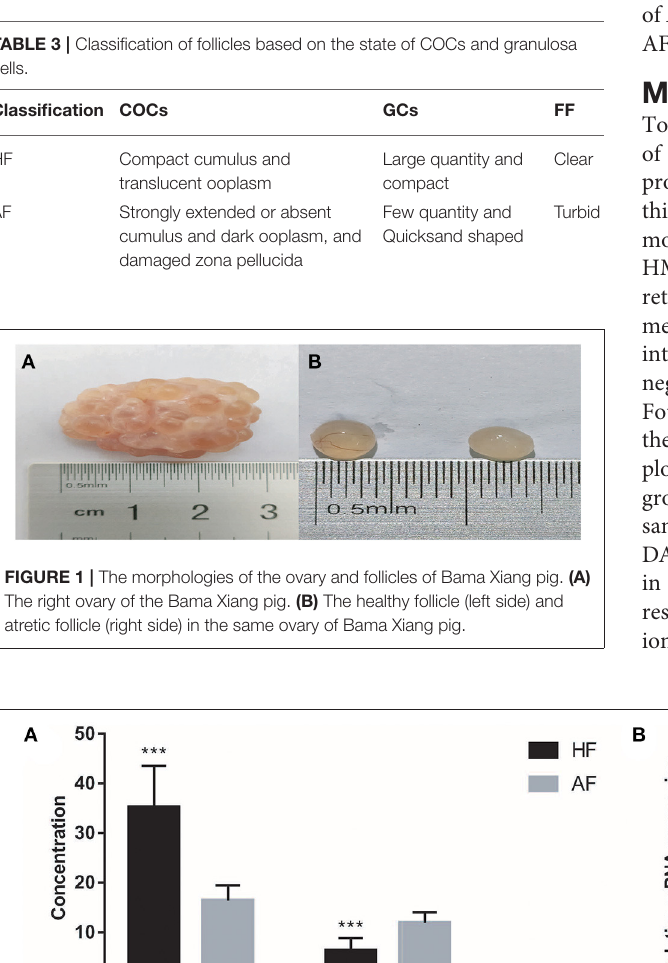
Frontiers in Veterinary Science |